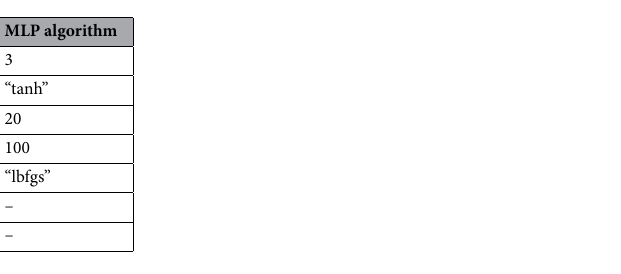
Table 4. LSTM and MLP hyper-parameters and forecasting